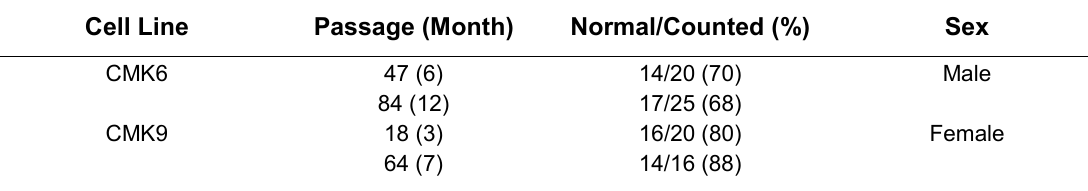
Karyotype Analysis of Two ES Cell Lines of the Cynomolgus